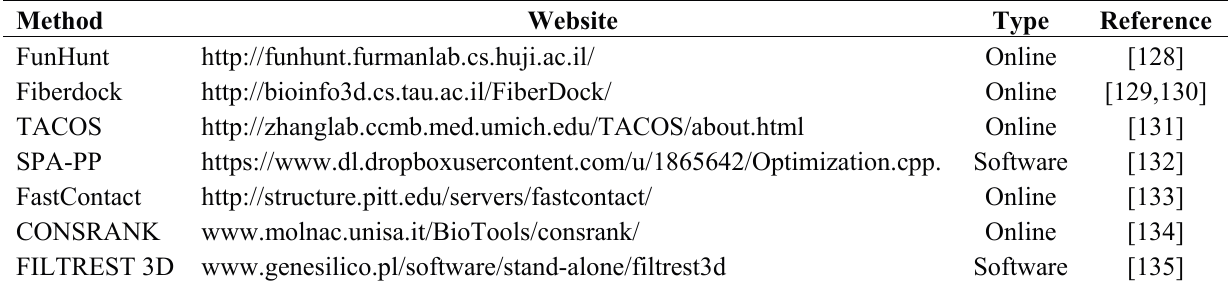
Table 3. List of scoring, and refining methods/software and